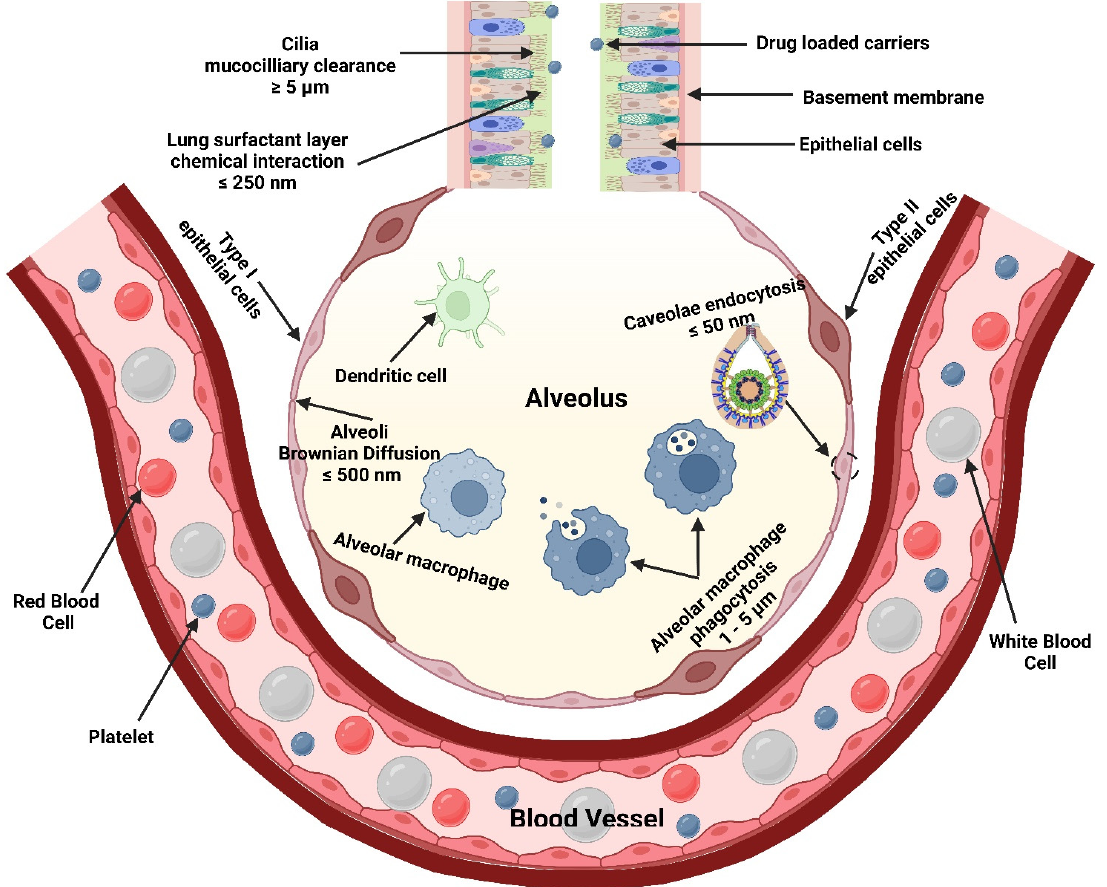
Figure 9. Inhaled particle sizes have different routes for distribution, clearance, and